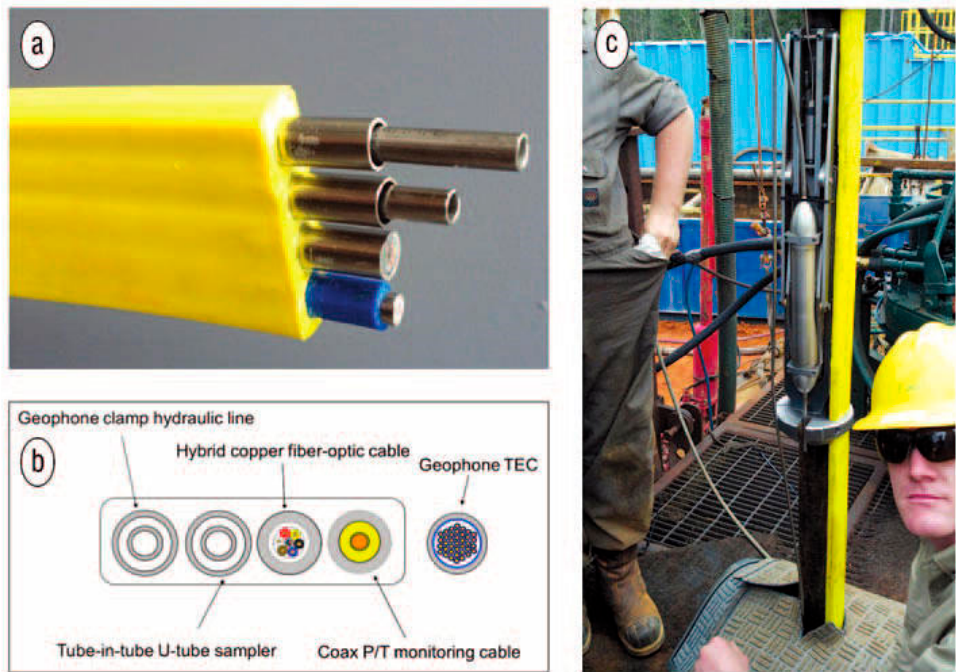
Figure 2. Colocated fiber and downhole geophone installation in early experimental deployment. ( a ) Image of flatpack deployment including the fiber and ( b ) its schematic representation. ( c ) Flat and borehole geophone clamped on the tubing. Figure and caption from Daley et al. (2013), The Leading Edge.